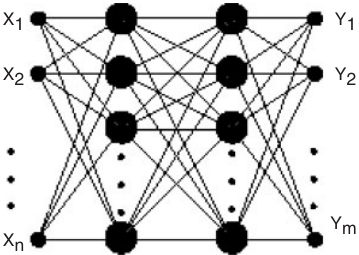
Figure 1 Two-layer neural network.